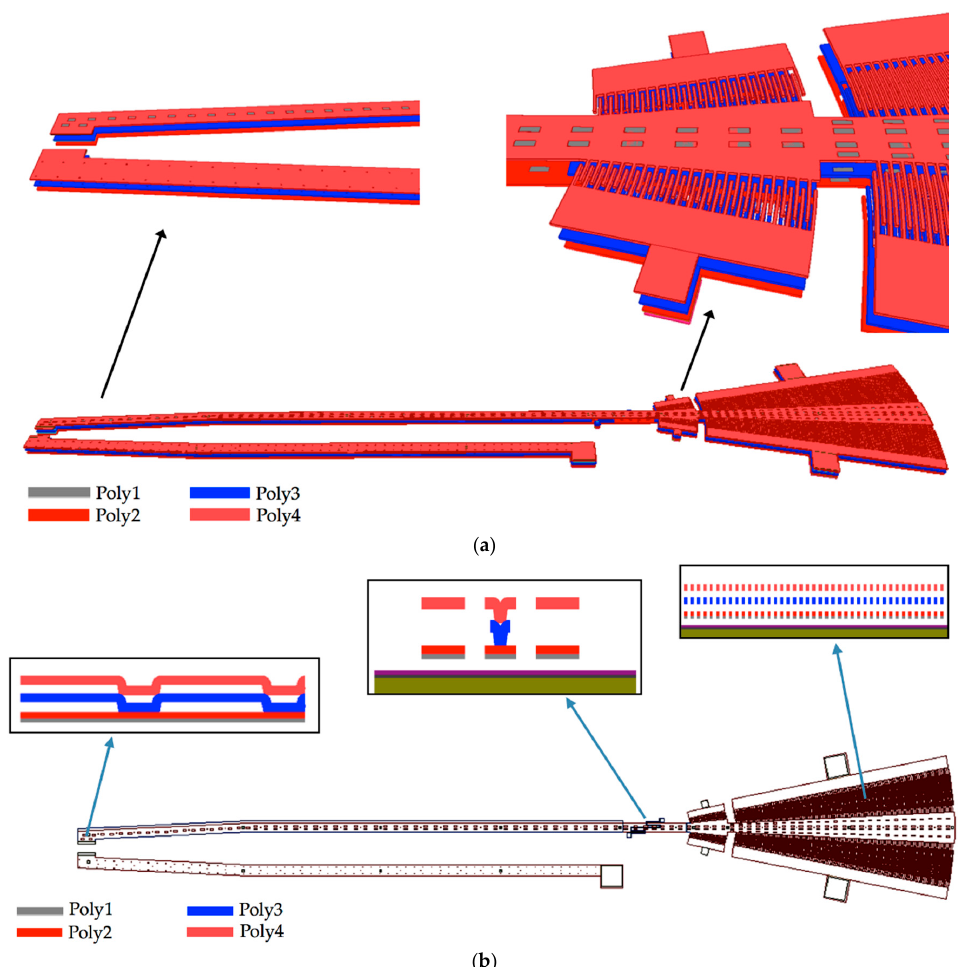
Figure 3. ( a ) 3D view and ( b ) layout of the microgripper based on the SUMMiT V surface-micromachining process.